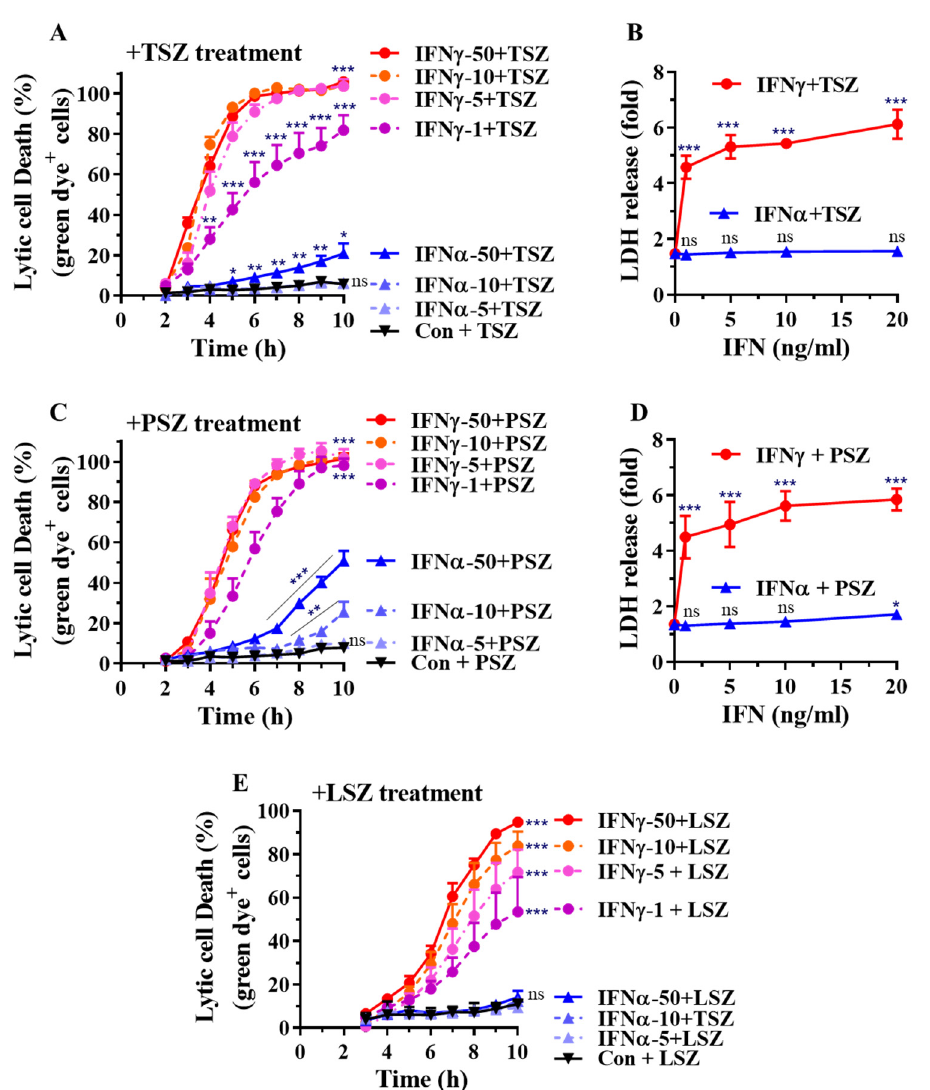
Figure 3. Dose-dependent effects of IFN γ and IFN α on AEC necroptosis. ( A , C , E ) Mouse primary AECs were incubated with control PBS (Con.), IFN α 2 at 5, 10, or 50 ng/mL, or IFN γ at 1, 5, 10, or 50 ng/mL for 24 h. The cells were then subjected to real-time necroptosis assay as described in Figure 2 in response to TSZ ( A ), PSZ ( C ) or LSZ ( E ). The percentage of lytic cell death (green dye + cells) was calculated by comparison to the maximal fluorescence induced by a lysis buffer in each group and is presented as mean ± SE. In panel ( A ): Con., IFN γ -1, IFN γ -10, IFN γ -50, or IFN α -50+TSZ, n = 10; other treatments, n = 4–7. In panel ( C ): Con., IFN γ -50, or IFN α -50+PSZ, n = 10; other treatments, n = 4–7. In panel ( E ): Con.+LSZ, n = 8; IFN α -5+LSZ, n = 3; all other treatments, n = 6. Two-way ANOVA and unpaired Student’s t test were performed in ( A , C , E ). * p < 0.05; ** p < 0.01; *** p < 0.001 versus control (Con.) in each treatment group. NS, no significance. The orders of each agonist-induced percentage of lytic cell death were listed on the right in each panel. ( B , D ) Mouse primary AECs were incubated with IFN α 2 or IFN γ at 0, 1, 5, 10, or 20 ng/mL for 24 h, then treated for 6 h with necroptosis inducers TSZ ( B ) or PSZ ( D ). LDH activities in cell supernatant were determined and the relative changes are presented as fold ± SE of individual control groups without treatment of necroptosis inducers. Panel ( B ), n = 4–7; panel ( D ), n = 3–6. One-way ANOVA was performed in ( B , D ). *** p < 0.001 versus control (0 IFN) in each treatment group. NS, no